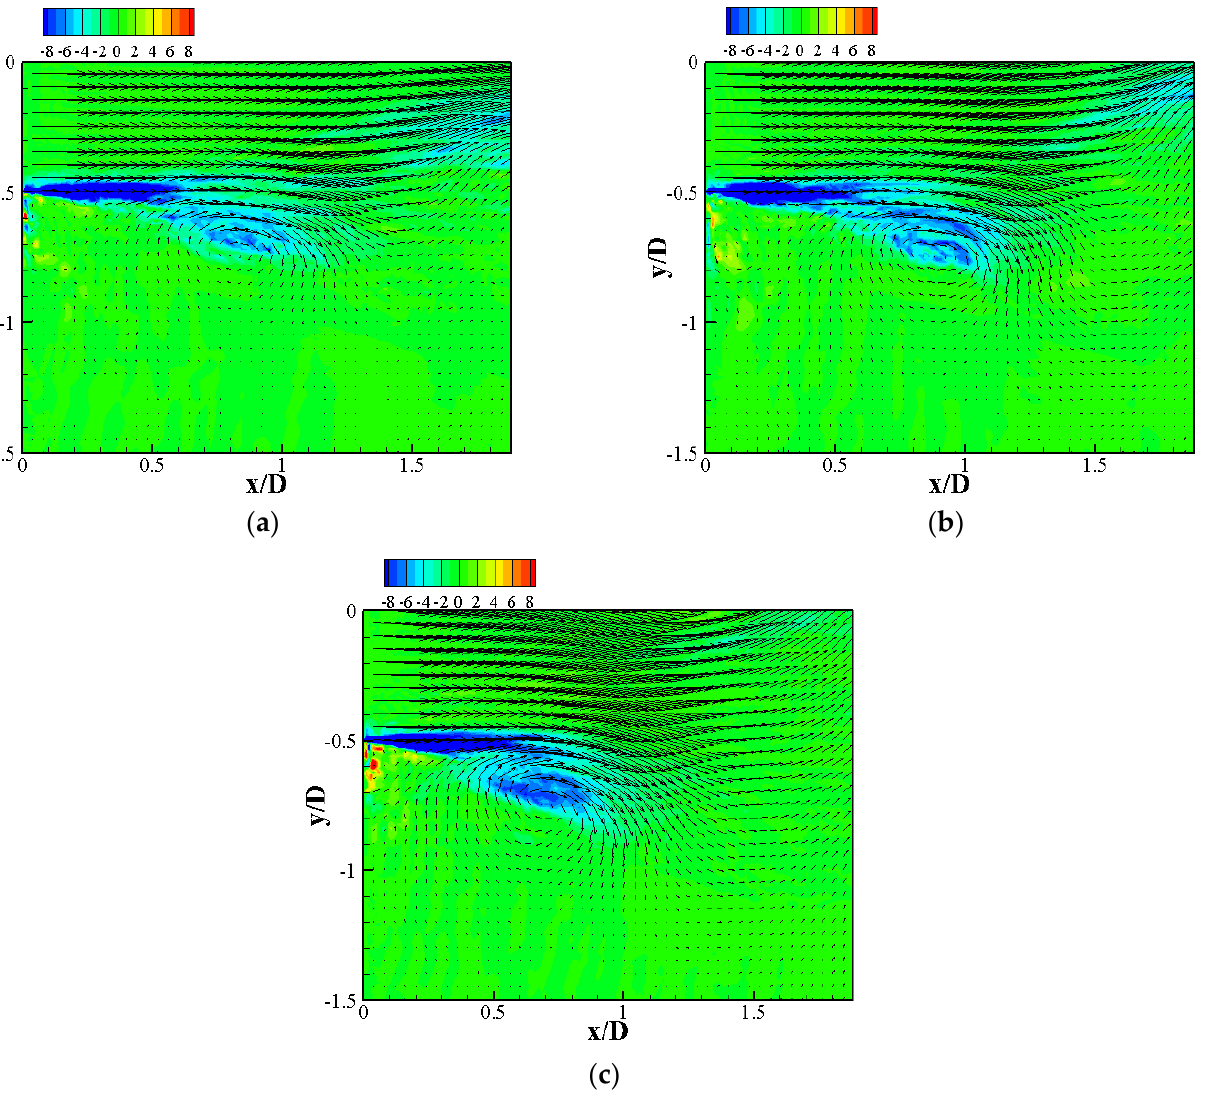
Figure 14. Spanwise vorticity in the forced plane in the near field under different amplitudes, normalized by U j / D . ( a ) MFR = 0.67%, ( b ) MFR = 1%, ( c ) MFR = 1.5%.